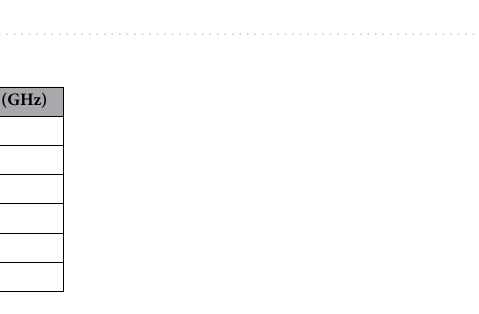
Table 1. Comparison between the performances of the proposed antenna and the literature.